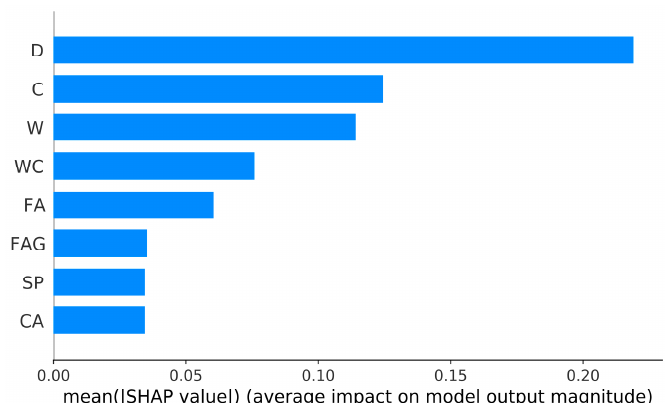
Figure 8. Feature importance of the compressive strength prediction of FAC.